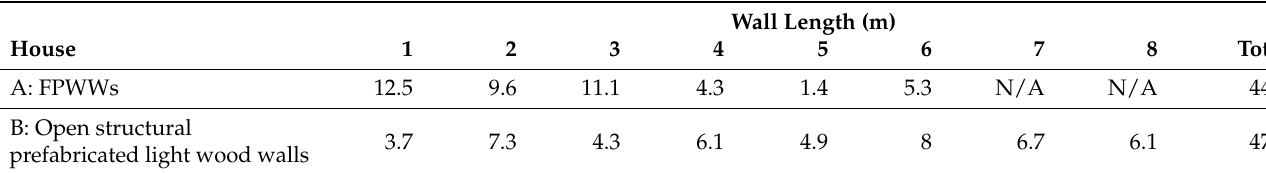
Table 2. Length of the walls for houses A and